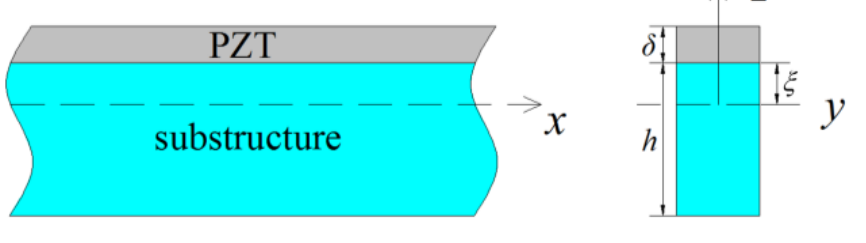
Figure 1. A composite beam.